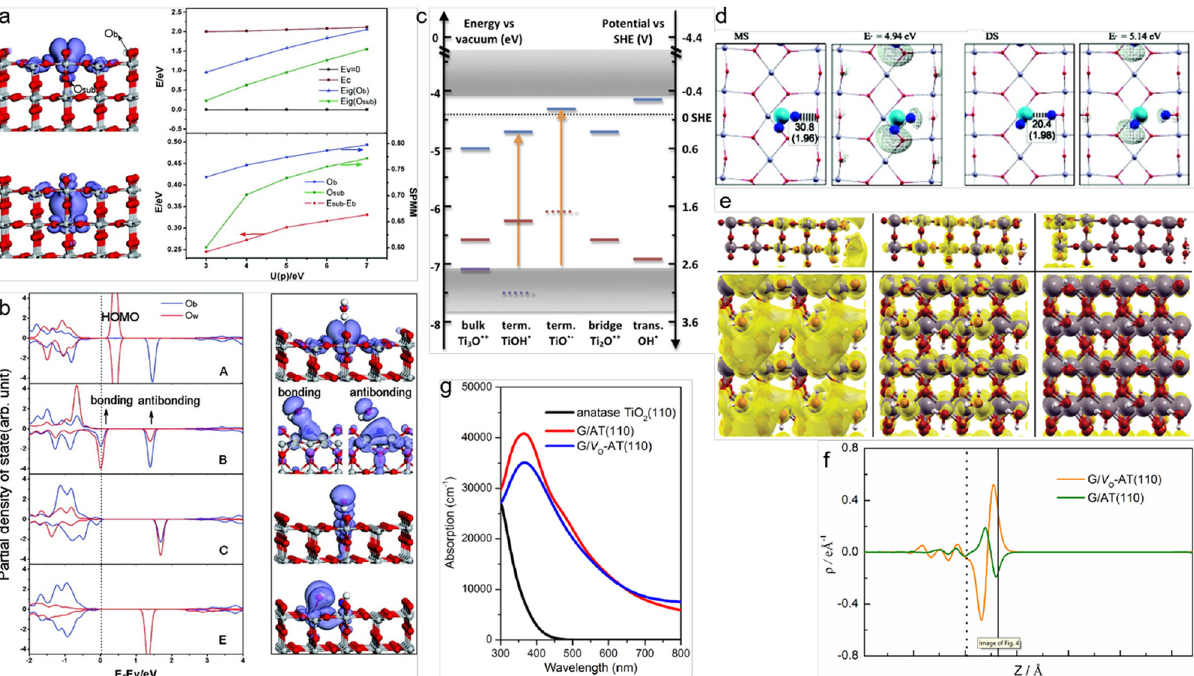
Figure 6: ( a ) Iso - density surface of hole orbital trapped at O b and O sub , the dependence of eigenvalues of the hole orbital trapped at O b and O sub , SPMM of O b and O sub and relative energy for hole trapping at these two sides, ( b ) PDOS of O b and O w in the states A, B, C, and E, and corresponding iso - density surface of trapped hole orbital, reprinted with permission from ref. [ 170 ] , Copyright ( 2012 ) American Chemical Society. ( c ) Alignment of the vertical and adiabatic electronic energy levels for the trapped holes in TiO [ 171 ] , 2 , reprinted with permission from ref. Copyright ( 2014 ) American Chemical Society. ( d ) The optimized H 2 O adsorption structures for the molecular adsorption and dissociative adsorption models, reprinted with permission from ref. [ 173 ] , Copyright ( 2009 ) American Chemical Society. ( e ) Charge densities for the wet electron state ( left panel ) , the surface state ( middle panel ) , and the bulk state ( right panel ) of the wet electron system, reprinted with permission from ref. [ 174 ] , Copyright ( 2009 ) American Chemical Society. ( f ) The planar averaged charge density di ff erence along the direction perpendicular to the graphene slab. ( g ) Calculated part of the UV – vis absorption spectra, reprinted with permission from ref. [ 176 ] , Copyright ( 2017 )